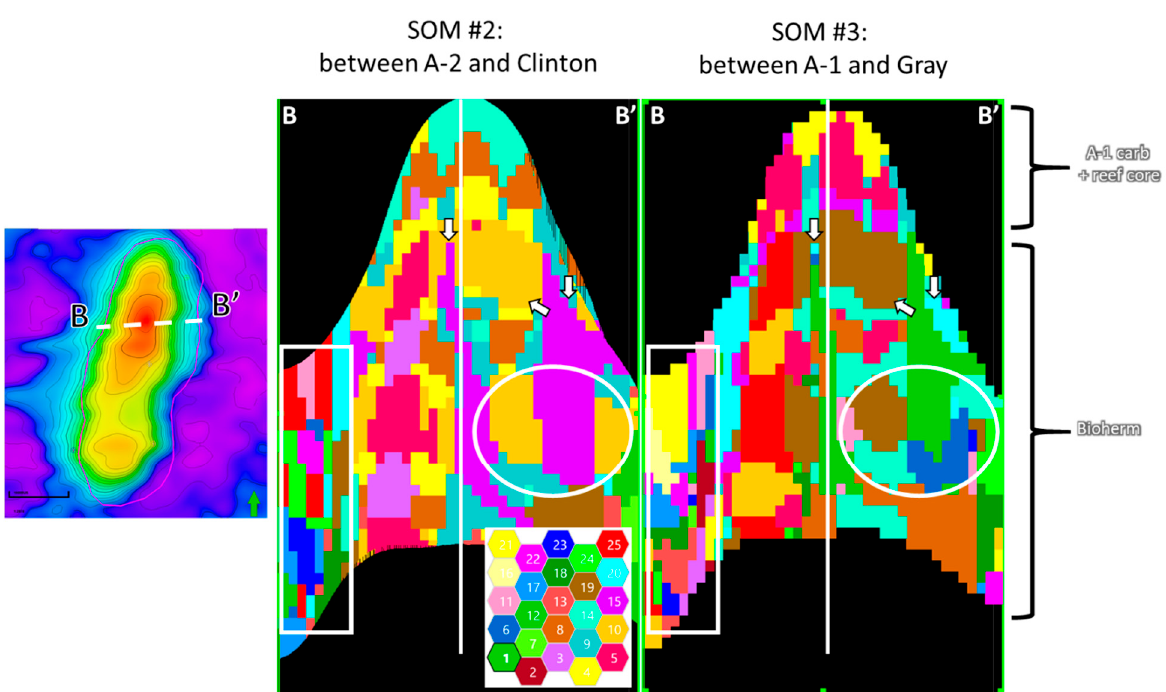
Figure 6. Self-organizing map (SOM) comparison between the second and third SOMs. The second SOM, on the left, was created with more input data, while the third SOM, on the right, was created with less. The white circle and rectangle are showing the same area of each SOM being characterized by different amounts of neurons. The SOM on the left created with more input data tended to use less neurons to characterize the areas. The arrows are pointing to places where the general trends were similar, with only slight differences in the amounts of neurons used for characterization. The third SOM was used for the remainder of the analysis.